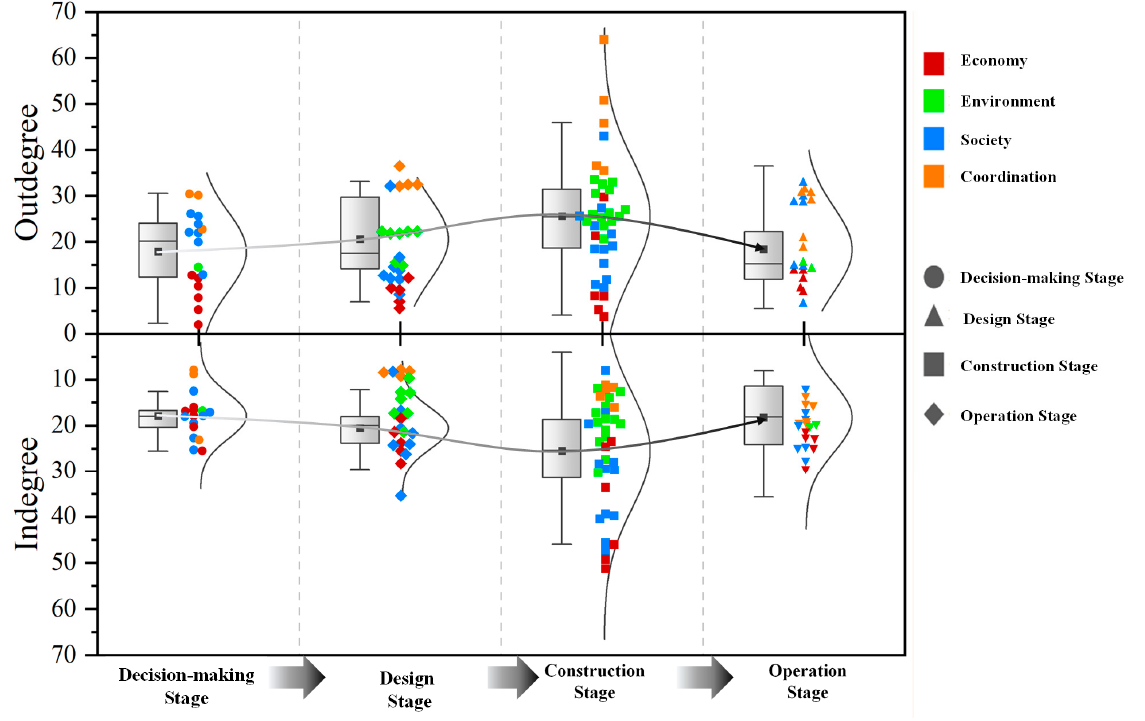
Figure 3. The evolution of out ‐ degree and in ‐ degree.